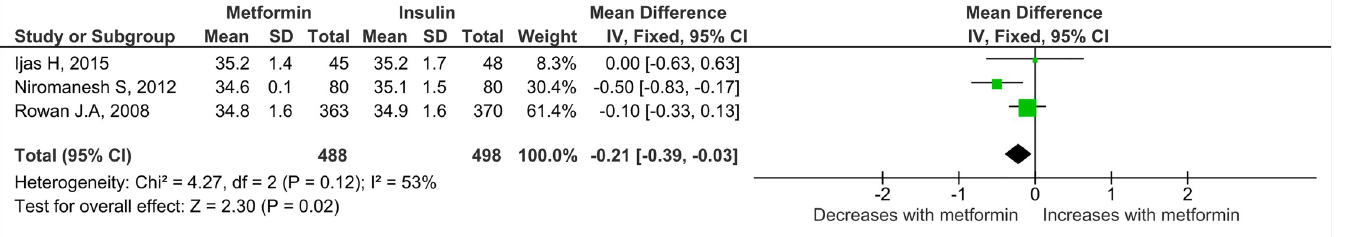
PLOS Medicine| https://doi.org/10.1371/journal.pmed.1002848 August 6,